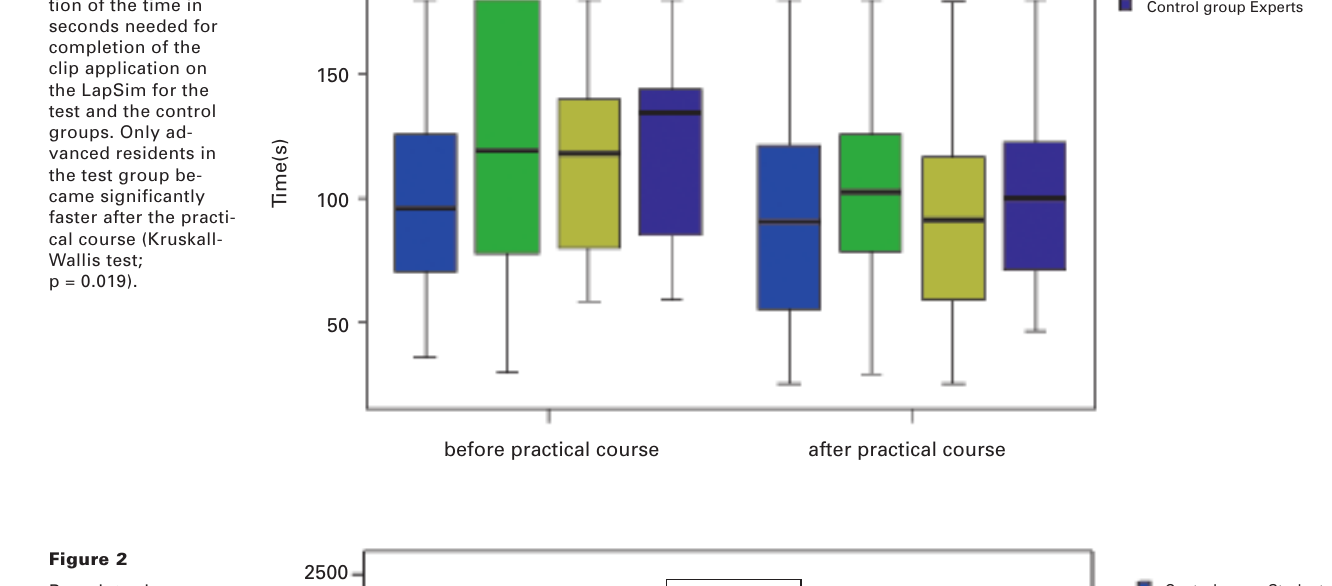
Figure 2 Box plots show mean and standard devia- tion of the error scores of the clip application on the LapSim for the test and the control groups. Only ad- vanced residents in the test group re- duced significantly their error score after the practical course (Kruskall-Wallis test; p =